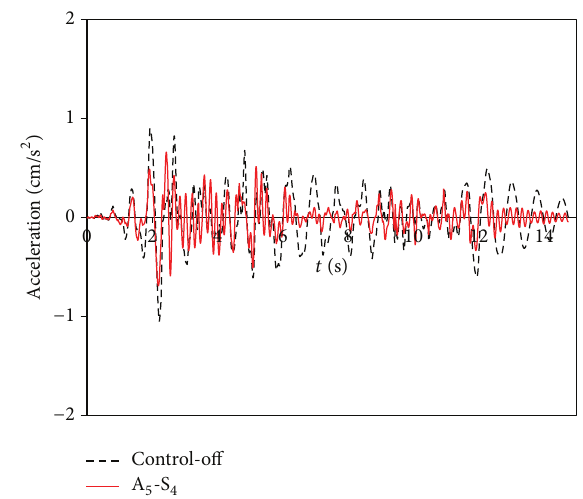
Figure 6: The time history acceleration for the fifth-story of shear building excited by the Elcentro